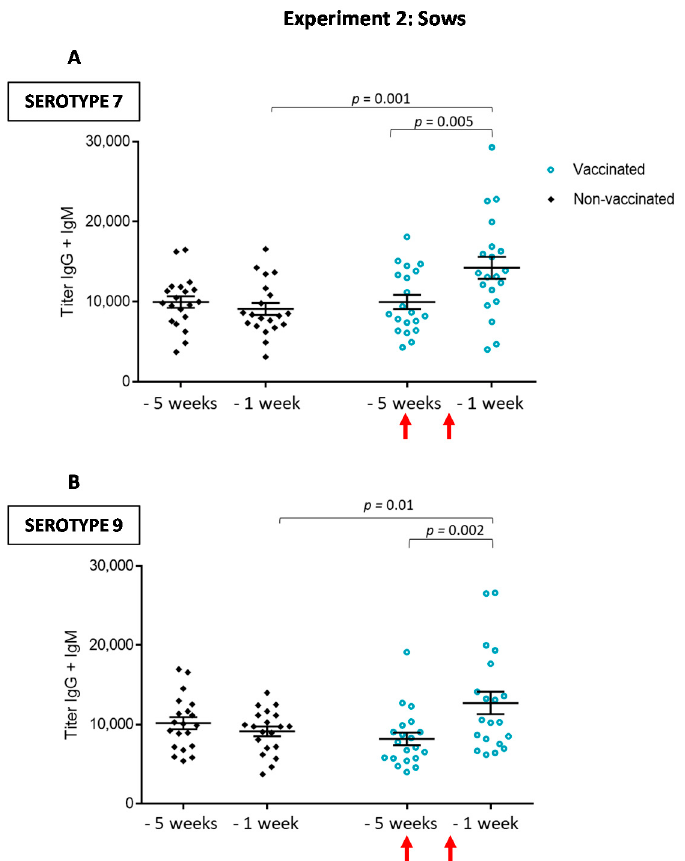
Figure 6. Experiment 2: Total Ig levels against S. suis serotype 7 ( A ) or serotype 9 ( B ) in sows. Blood samples were collected one and five weeks before farrowing from 20 vaccinated and 20 non-vaccinated sows to follow the immune response. The vaccine was administered at five and three weeks before farrowing. Total Ig [IgG + IgM] titers were determined by ELISA. Antibody titers for individual sows are shown with horizontal bars representing mean ± SEM. Values significantly different are shown in the graph with corresponding p value. Arrows indicate first and second vaccination doses.